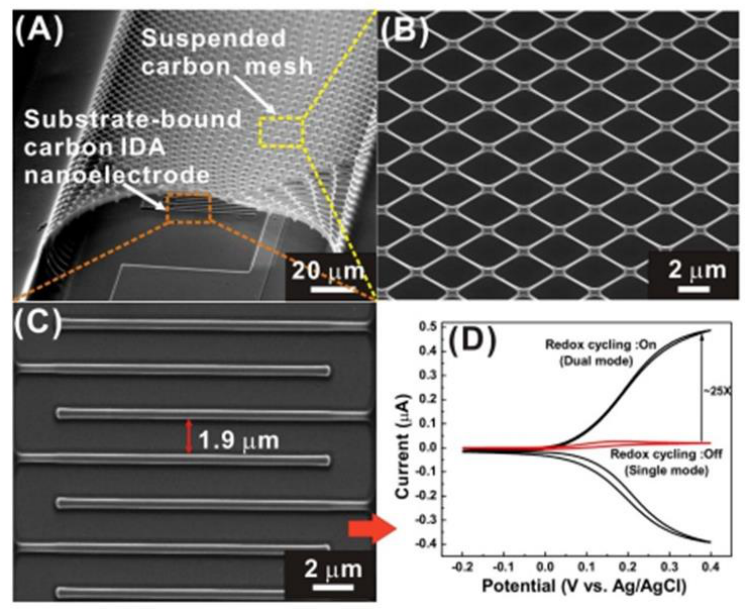
Figure 7. ( A ) SEM image of a 3D carbon system (tilted-view); ( B ) enlarged top-view images of a suspended carbon mesh; ( C ) substrate-bound carbon IDEA nanoelectrodes; and ( D ) cyclic voltam- mograms of 1 mM PAP in 0.1 M PBS at the IDEA nanoelectrodes. Both the combs were scanned from − 0.2 to 0.4 V vs. Ag/AgCl in the single-mode (red line). In the dual mode, the potential of the generator comb was scanned the same as the single-mode while the collector comb was held at − 0.3 V (black line). Amplification factor (AF) = sum of dual-mode current from IDEA/sum of single-mode current from IDEA. Reprinted from [139]. Copyright © 2022 Elsevier B.V. All rights reserved.